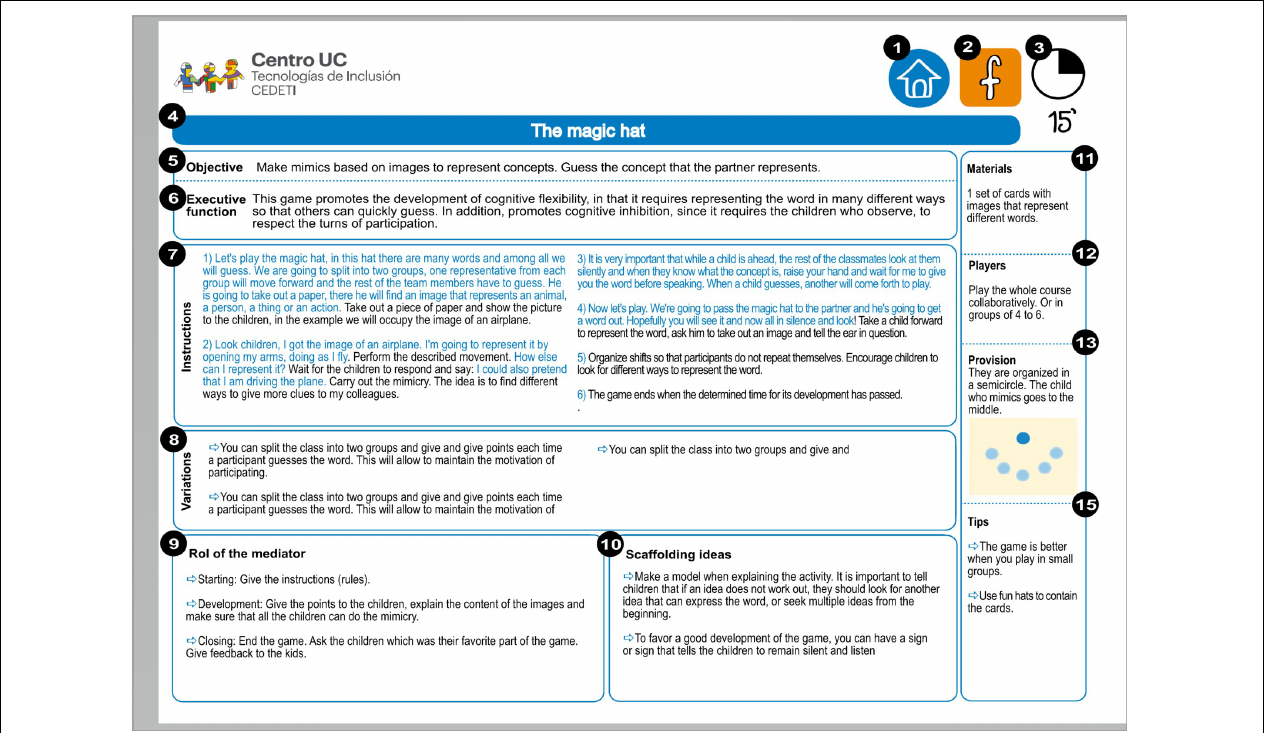
FIGURE 3 | Sample of a homogenization sheet. (1) Type of game: playground, expression, or classroom games. This is a classroom game. (2) Main EFs component developed. (3) Approximate duration of the game. (4) Title of the game. (5) Aim of the game. (6) Way in which executive functions are developed. (7) Instructions. (8) Ways in which the game can be modified. (9) Role of the mediator in each phase of the activity. (10) Scaffolding ideas. (11) Materials needed to conduct the activity. (12) Number of players and organization. (13) Suggested spatial arrangement. (14) Additional suggestions.